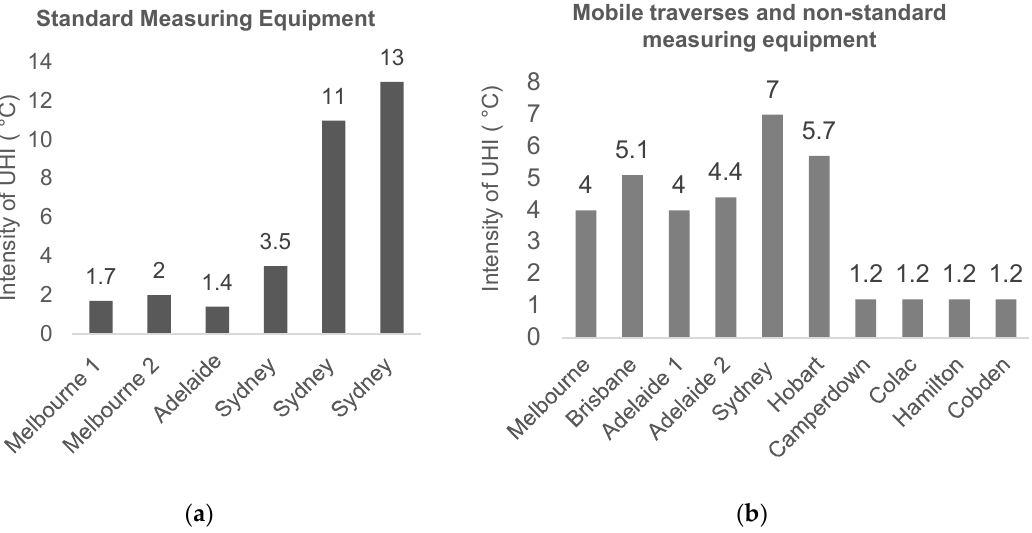
Figure 1. The intensity of the UHI effect in Australian cities and regions ( a ) using standard measuring equipment; and ( b ) nonstandard measuring equipment.